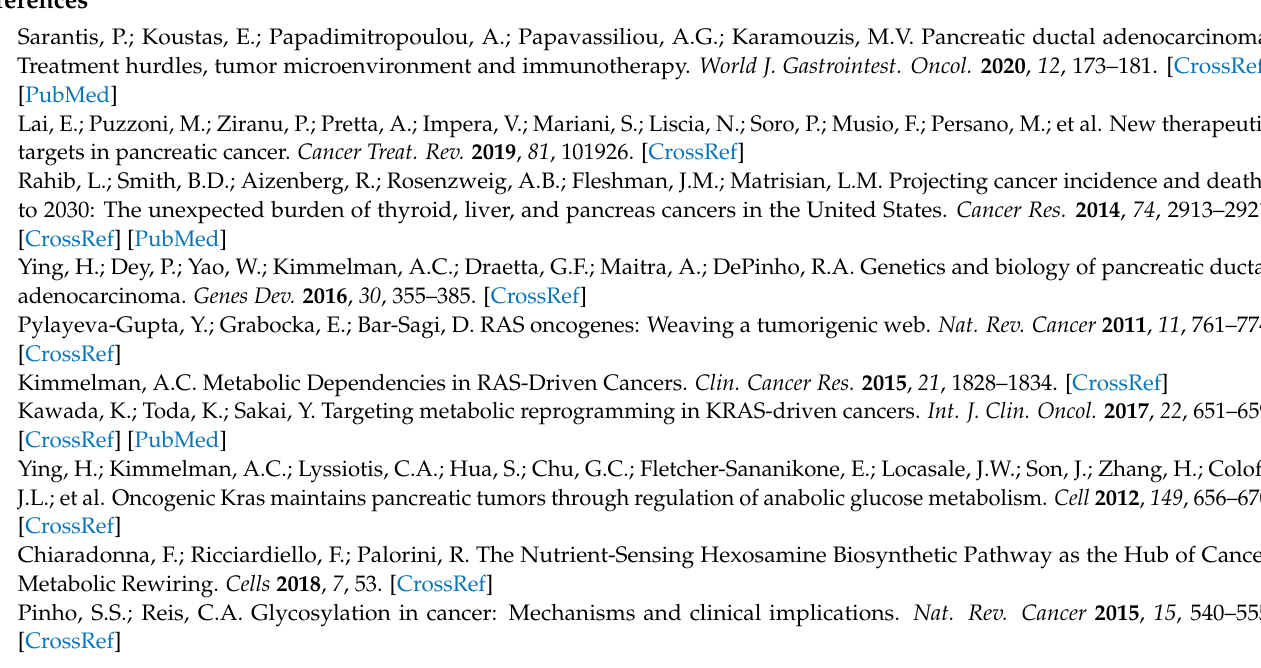
FR054 treatment; Figure S6: Combined 48h-treatment of KRASmut MIA PaCa-2 cells with FR054 and the pan-RAS inhibitor BI-2852; Figure S7: Combined treatment of KRASwt BxPC-3 cells with FR054 and the pan-RAS inhibitor BI-2852; Figure S8: Combined treatment of KRASmut SU.86.86 and Capan-1 cells with FR054 and the pan-RAS inhibitor BI-2852; Figure S9: Upon treatment with FR054 EGFR accumulates at ER and Golgi